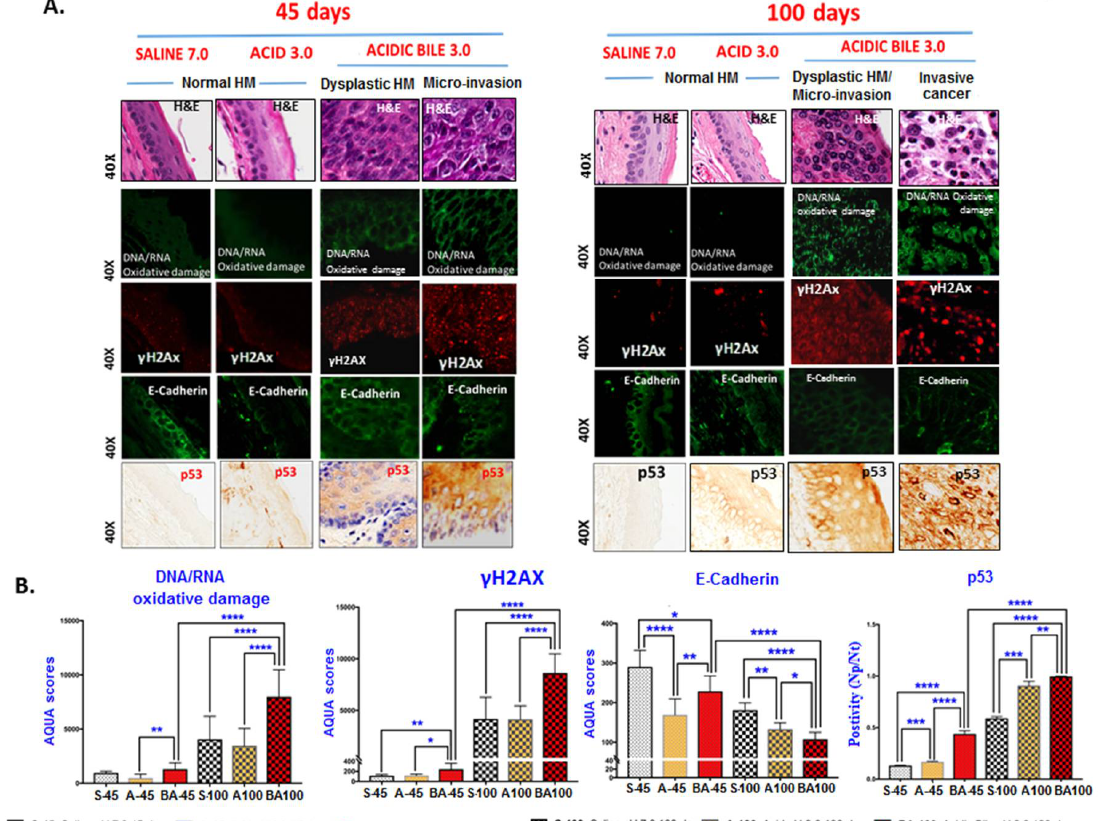
Figure 3. Acidic-bile-induced DNA damage and increased expression of p53 at 45 days and 100 days of exposure. ( A ) Immunofluorescence staining was used for DNA / RNA oxidative damage markers (green), γ H2AX (p-H2AX (S139)) (DyLight ® 549 red) and E-Cadherin (DyLight ® 488 for green) (DAPI was used for nuclear staining (not seen here)). IHC analysis for p53 (brown) was performed using chromogenic staining. ( B ) Graphs created using GraphPad Prism 7.0 demonstrate the statistically significant di ff erences of the mean AQUA (automated quantitative analysis) scores for DNA / RNA oxidative damage markers (nuclear and cytoplasmic), γ H2AX (nuclear), and E-Cadherin (membrane / cytoplasmic) or cytoplasmic positivity for p53 (positivity = positive p53 staining / total number of cells; Image Scope software) between acidic bile vs. controls, and between acidic bile 45-day vs. acidic bile 100-day treated groups (* p < 0.01; ** p < 0.001; *** p < 0.0001; **** p < 0.00001; t -test; multiple comparisons using Holm–Sidak; GraphPad Prism 7.0). The BA 100 in the bar graphs represents both dysplastic HM and invasive cancer.